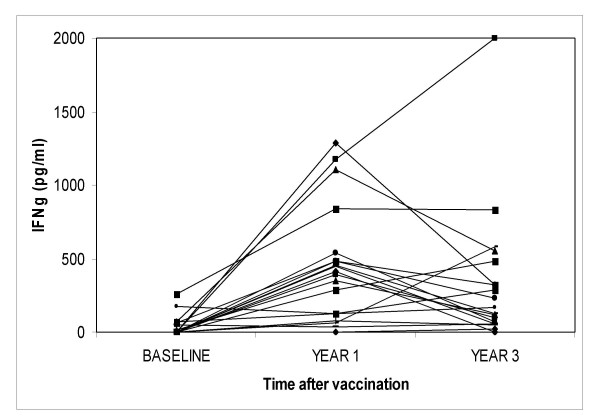
IFN-γ responses to M.tb PPD in UK teenagers tested before, one and three years after BCG vaccination. Each triplet of linked points represents IFN-γ response of vaccinated individuals at baseline, one (Year 1) and three (Year 3) years after vaccination with Glaxo 1077 BCG.